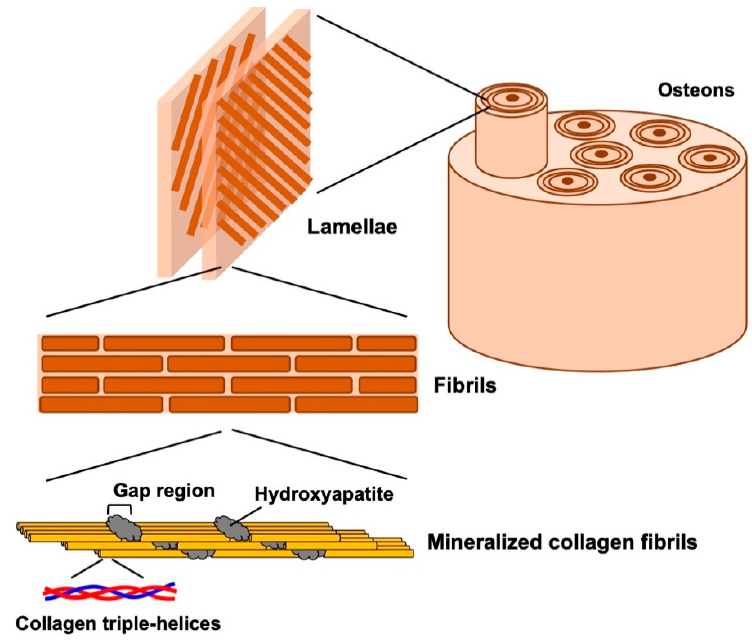
Figure 1. Hierarchical structural organization of bone.